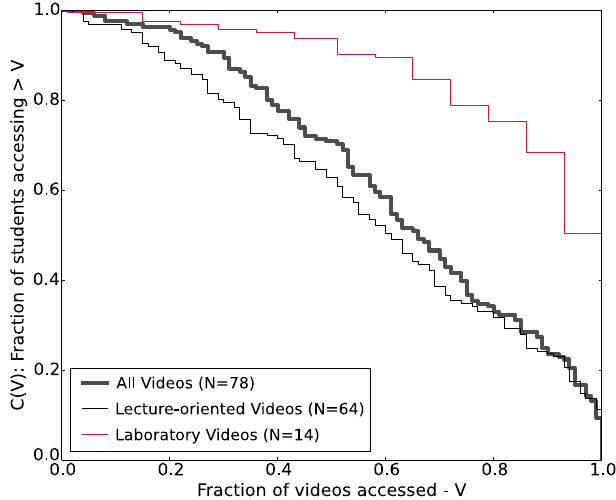
3. Complementary cumulative distribution function C ð V Þ showing the fraction of students accessing more than a certain proportion of videos in each group. Students are much more likely to access most or all of the laboratory videos in comparison to the lecture-oriented